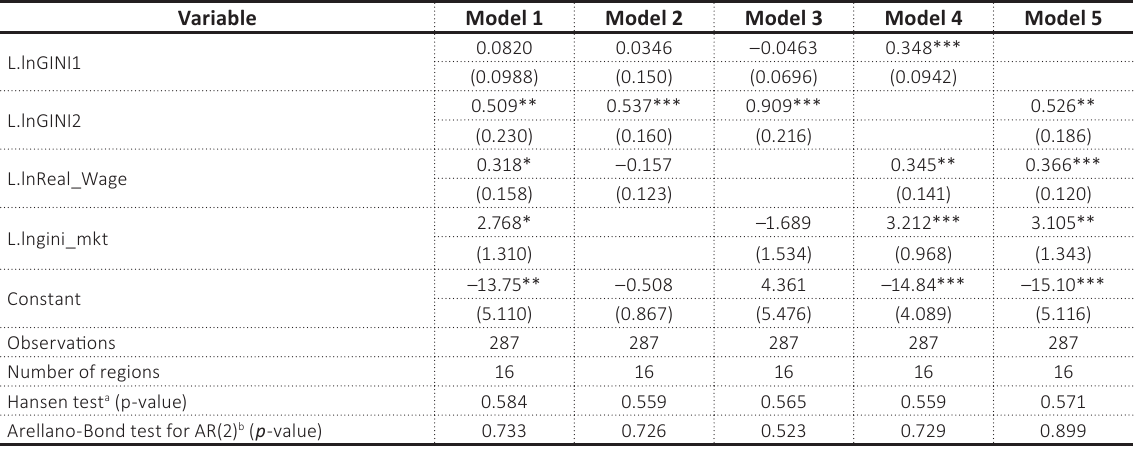
Table 4. Regression analysis results for regions with wage data (lag 1) (all models are